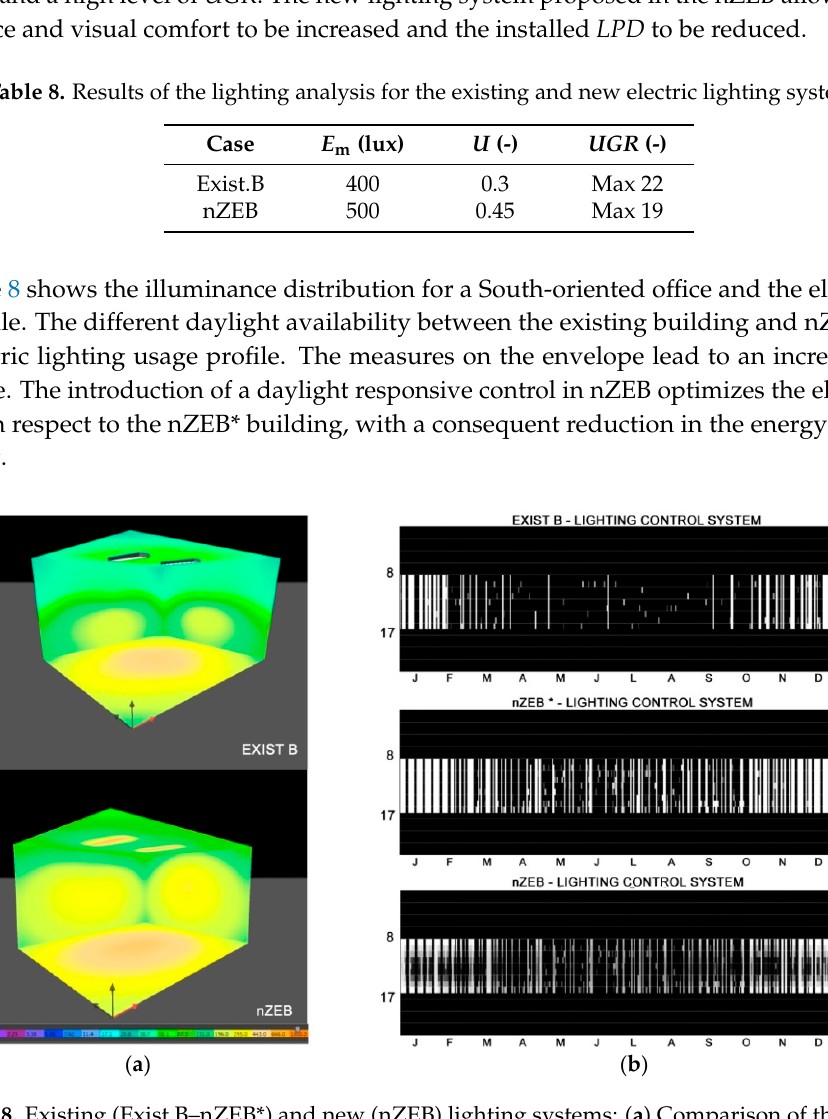
Figure 8. Existing (Exist.B–nZEB*) and new (nZEB) lighting systems: ( a ) Comparison of the lighting performance; ( b ) Comparison of the use profile. Table 8. Results of the lighting analysis for the existing and new electric lighting systems.